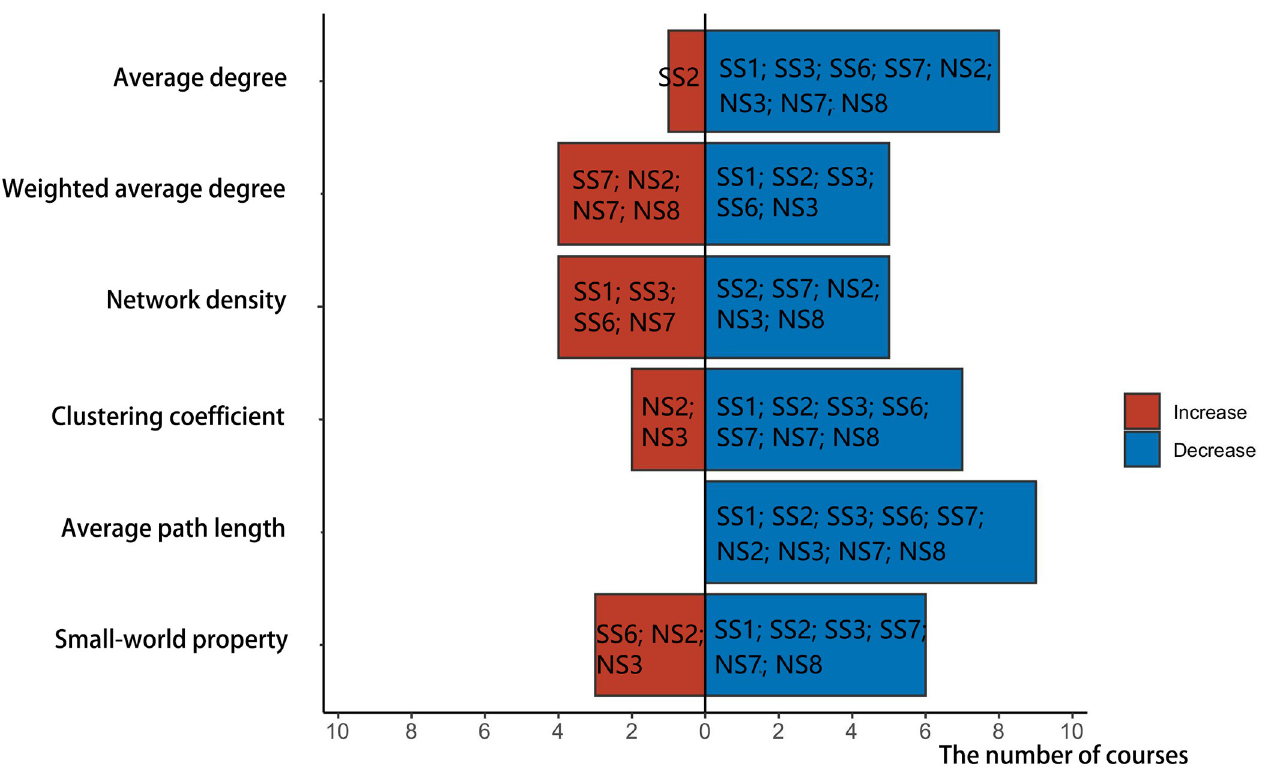
Fig 5. Changes in indicators of courses with decreased interaction scale from the COVID-19 outbreak to after the